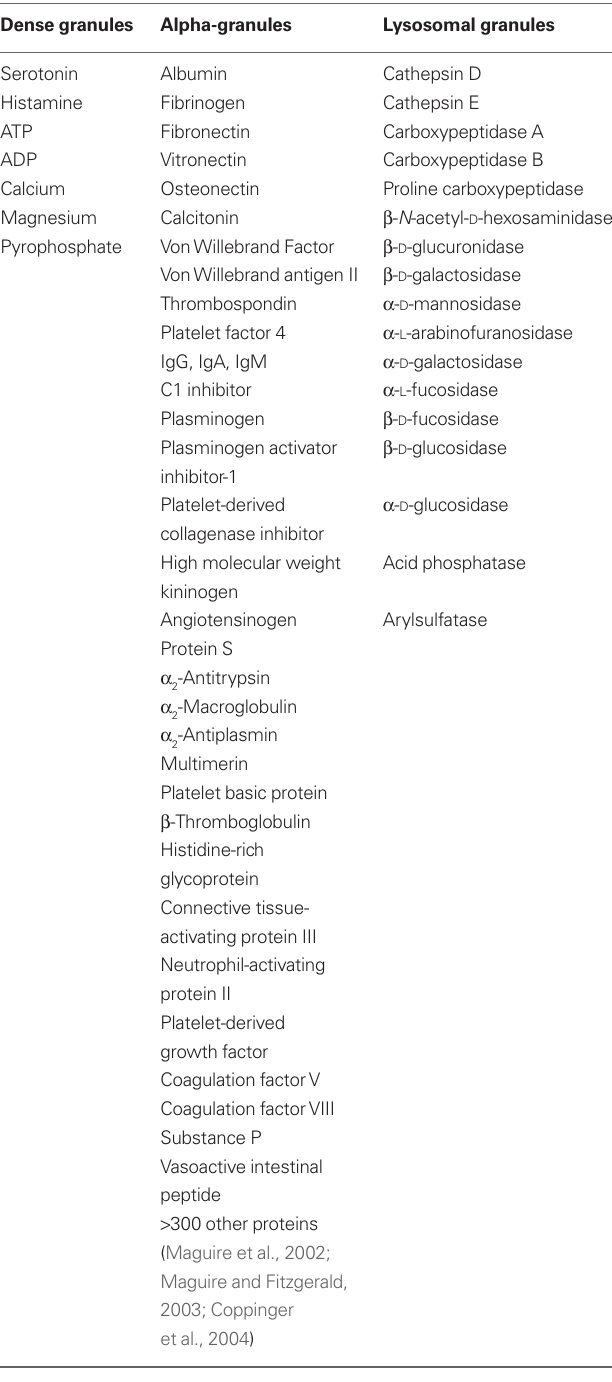
Table adapted from McNicol and Israels (1999).